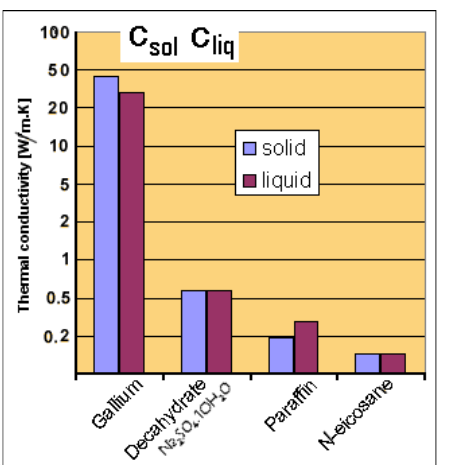
. Fig. 9. Characteristic property of the discussed four families of phase change materials are their very different thermal conductivities — note that the values are here plotted using logarithmic scale. The different conductivity coefficients can significantly influence the overall efficiency of the